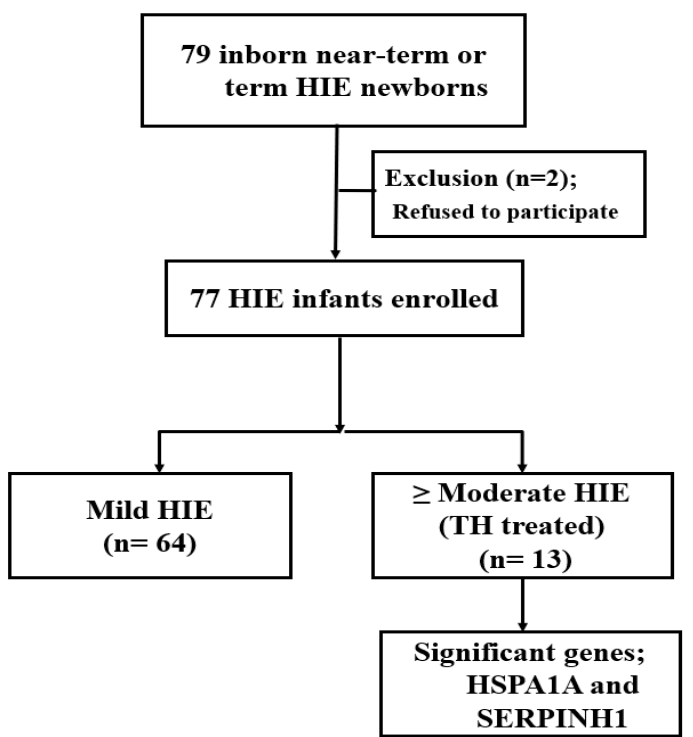
Figure 1. Study Flow chart; heat-shock protein genes predicting severe neonatal hypoxic-ischemic encephalopathy. Abbreviations: HIE, hypoxic ischemic encephalopathy; TH, therapeutic hypothermia; Hsp70, heat-shock protein family A; SERPINH1, serpin family H member 1.